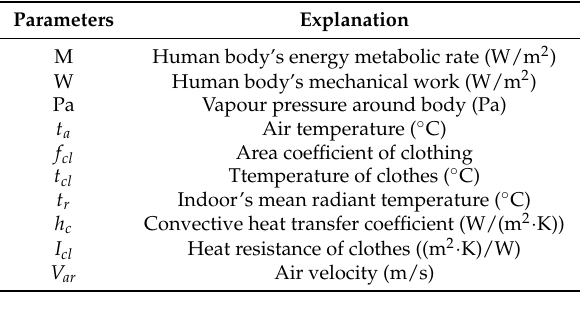
Table 1. The specific explanation of the parameters.